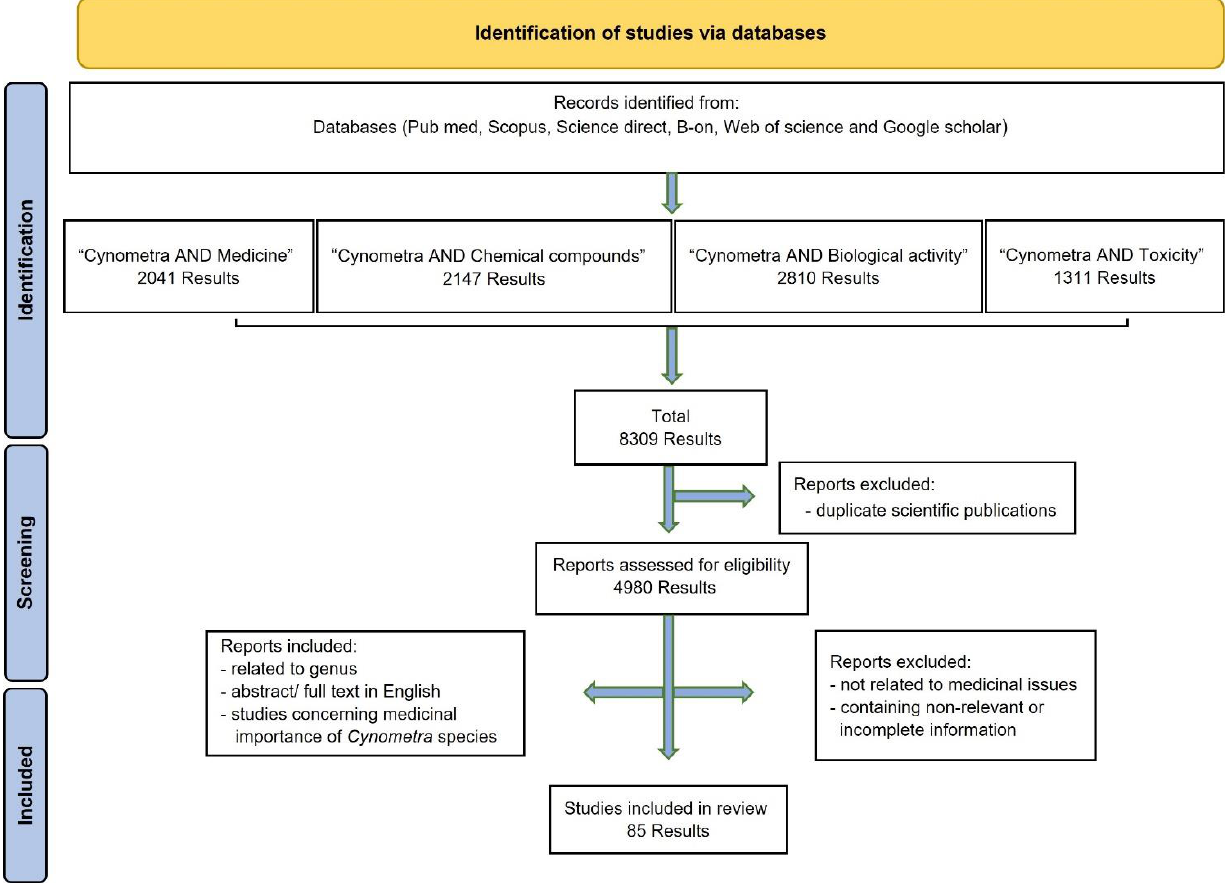
Figure 2. Data screening based on PRISMA methodology.